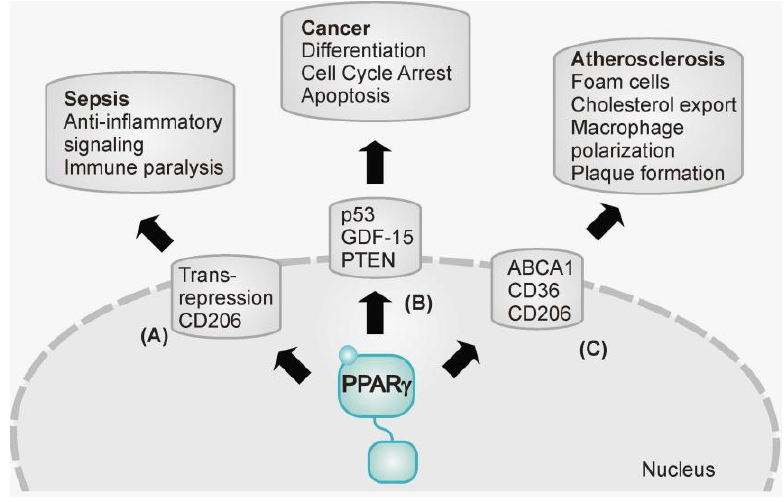
FIGURE 2. Summary of PPAR  -dependent effects in sepsis, cancer, and atherosclerosis. (A) In sepsis, the role of PPAR  is controversial. Transrepression of proinflammatory signaling during the initial phase of sepsis attenuates overwhelming inflammation, but may provoke insufficient bacterial clearance. Immune paralysis characterized by monocyte/macrophage desensitization as well as lymphocyte apoptosis is caused, in part, by PPAR  . Thus, PPAR  contributes to M2 macrophage polarization, for example, by induction of the M2 marker CD206 and repression of proinflammatory cytokine expression. Moreover, PPAR  seems to play an important role in lymphocyte apoptosis by a so-far-unidentified mechanism. (B) Cancer initiation and progression are inhibited by PPAR  -mediated expression of the tumor suppressor p53, the antiproliferative operating phosphatase PTEN, and the cell cycle arresting GDF-15. (C) PPAR  activation is involved in atherosclerosis by inducing CD36 expression, increasing oxLDL uptake, consequently fostering foam cell formation and contributing to M2 macrophage polarization. This might be involved in plaque formation due to incomplete phagocytosis of apoptotic debris and concomitant generation of the necrotic core. However, PPAR  -dependent induction of